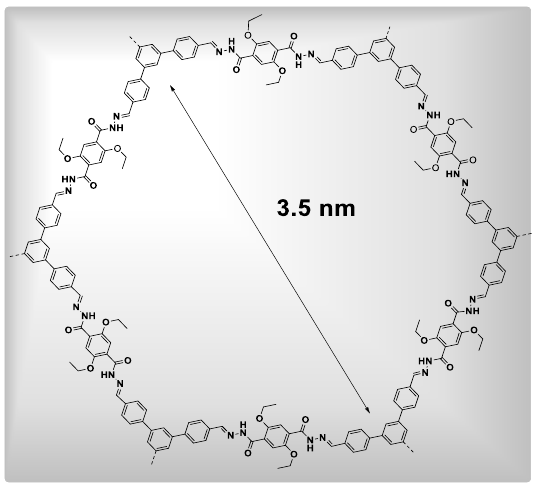
Figure 3. Imine-based COF having pore size of 3.5